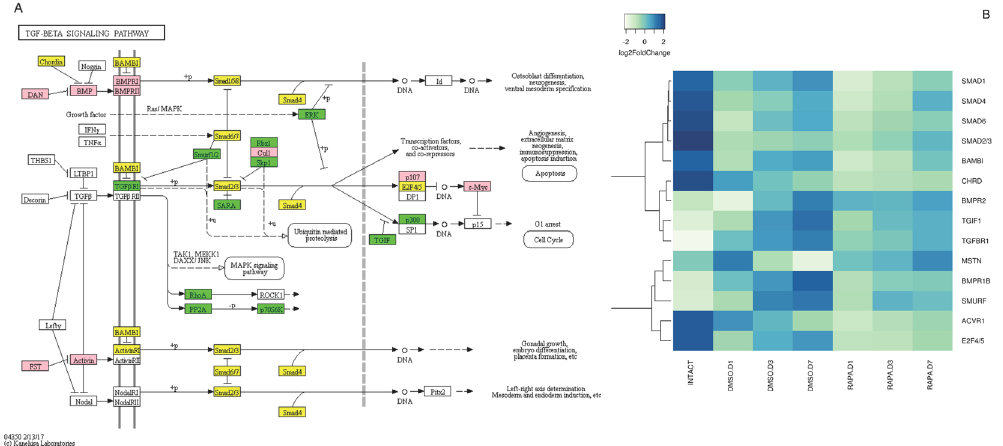
Figure 9. Identification of genes assigned to the TGF β /Activin signaling pathway in the G . lateralis YO/I/ DRESA transcriptomes. KAAS was used to identify genes annotated by BLAST against the specific insect database (Section 4.5) and assigned to a KEGG pathway 38–40 . ( A ) TGF β signaling pathway components/genes. Colored boxes indicate the presence of the genes identified in the ESA database. A pink colored box signifies the presence of an annotated gene that does not show a change in expression levels between intermolt and premolt; a green box indicates a significant increase in premolt transcript abundance relative to intermolt while yellow box indicates a decrease in transcript abundance. ( B ) Heat map showing the log2fold change of the FPKM values of the